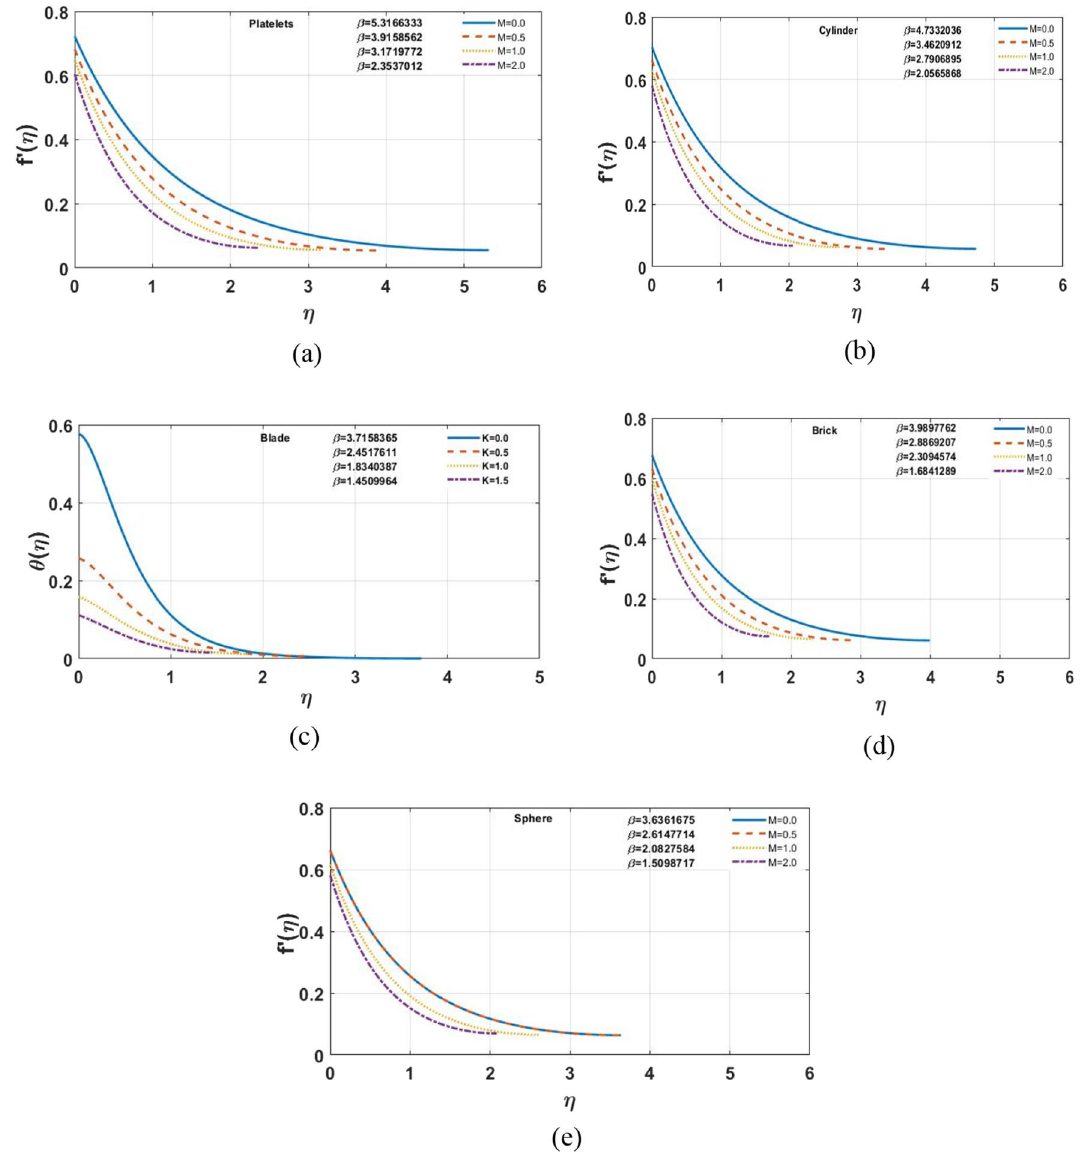
Figure 4. (a–e) Effects of Slip parameter M on the velocity profile for S = 0.4, K = 0.5 and φ =